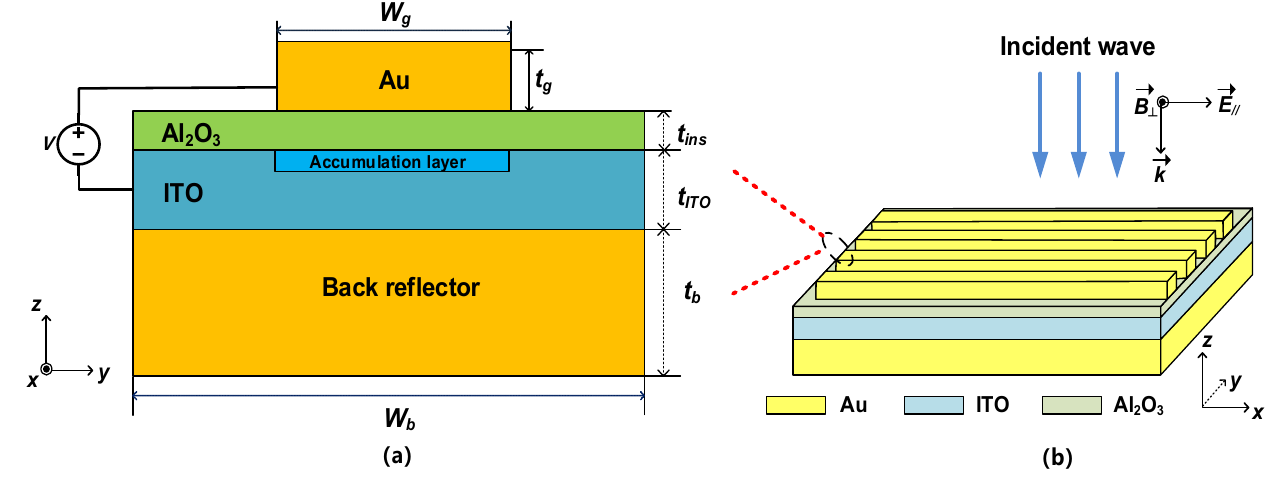
Figure 1. ( a ) Sectional view of the unit cell of the gate − tunable metasurface composed of an Au back reflector and an ITO layer followed by a gate dielectric on top of which Au antennas are located. The thicknesses of the antenna array, the insulator spacer, the ITO layer, and the back reflector are t g = 30 nm, t ins = 5 nm, t ITO = 20 nm, and t b = 100 nm, respectively. The antenna dimensions W b = 400 nm, and the electrode width is W g = 230 nm. A voltage bias is applied between the ITO layer and the top antennas. The applied voltage biases result in forming an accumulation/depletion region in the ITO layer at the top, and the TM wave is incident perpendicular to the direction of the metasurface. ( b ) Schematic of the metasurface. The period of the metasurface is 400 nm. Another parameter that determines performance is the choice of the plasmonic metal. The relative permittivity of Au is 1.59 [44,45], and our work function of Au is 5.1 eV, which is higher than that of ITO (4.4 eV) when the carrier concentration N 0 = 3.2 × 10 20 cm − 3 . In addition, selecting Au as a metal electrode in our metasurfaces ensures that the phase change is stable and continuous. The other is the choice of gate dielectric material. Alumina (Al 2 O 3 ) exhibits high DC permittivity and almost perfect interfacial properties with Si- based substrates. It is often employed in field-effect transistor fields as high dielectric constant gate dielectric materials and has a high breakdown field of up to 10 MV/cm. The average thickness t acc of the accumulation layer related to the carriers injected into the ITO layer in a standard metal–insulator–semiconductor structure [46] is given by: